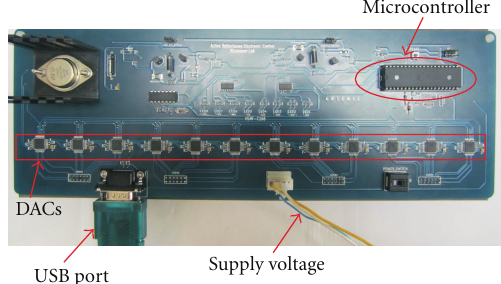
Figure 5: Photograph of the designed DACs